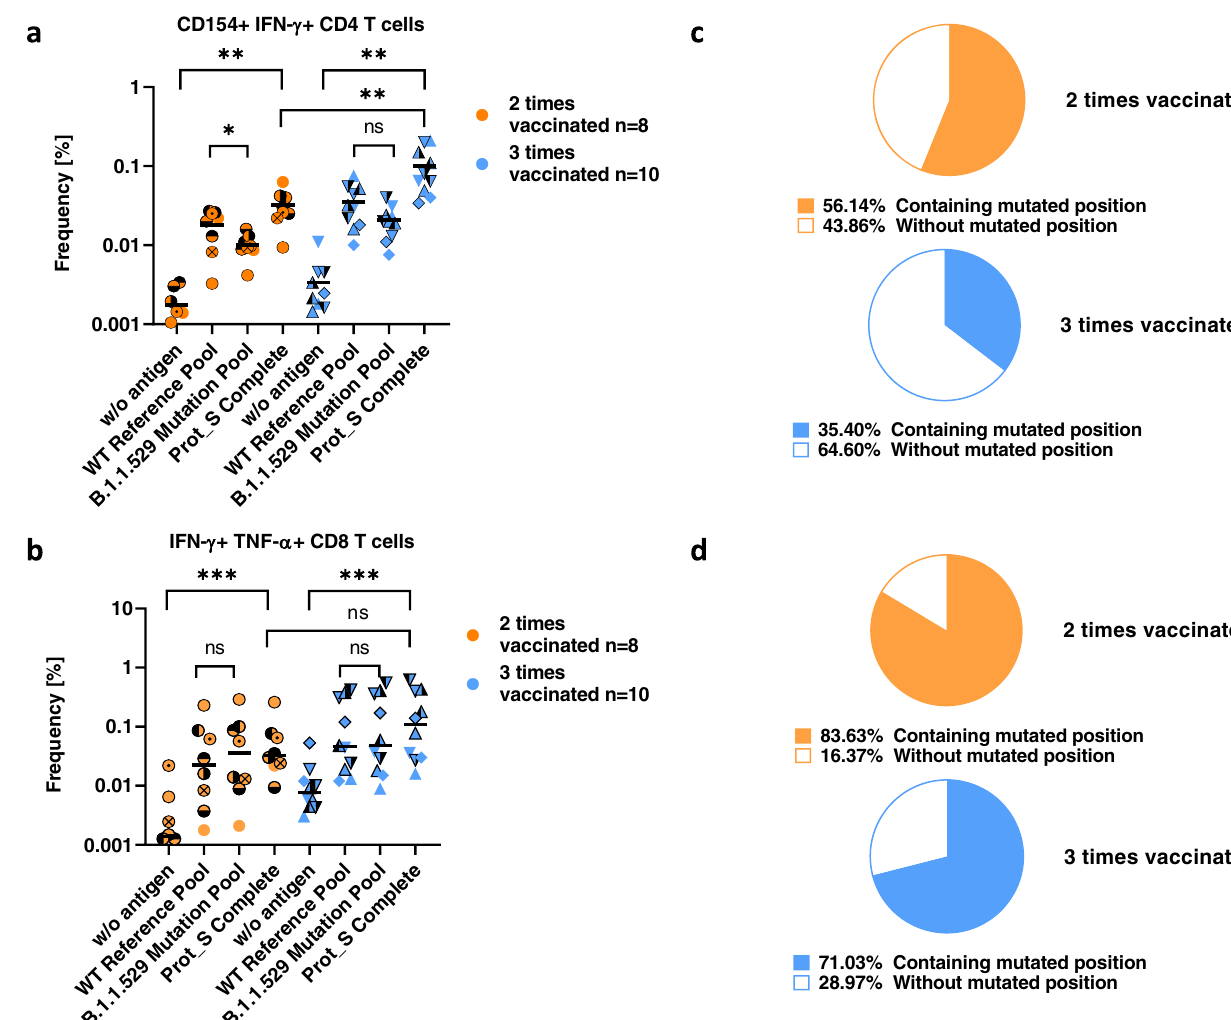
Fig. 1 T Cell reactivity in twice and triple vaccinated individuals upon stimulation with ancestral and B.1.1.529 Spike protein derived peptides. a The frequency [%] of CD154 + IFN- γ + cells among CD4 T cells and ( b ) of IFN- γ + TNF- α + cells among CD8 T cells are shown on the Y -axes. Horizontal lines indicate the mean. The X -axes indicate the peptide pools used for stimulation. Each symbol represents a single individual. Orange refers to 2 times ( n = 8) and blue to 3 times ( n = 10) vaccinated individuals. As CD4 T cells are normally distributed, student´s T tests with Welch correction were used for calculation of signi fi cance. As CD8 T cells are not normally distributed, Mann – Whitney U-tests were performed. n.s. not signi fi cant, * p < 0.05, ** p < 0.01, *** p < 0.001. c Cake diagrams to determine the amount of the CD4 response and ( d ) the CD8 response originating from the unmutated peptides, which contain a mutated amino acid in B.1.1.529. The color- fi lled portions indicate the amount of the T cell response from the wildtype peptides, which contain a mutation in B.1.1.529. Empty areas refer to the T cell response from peptides without mutations. Orange refers to 2 and blue to 3 times vaccinated